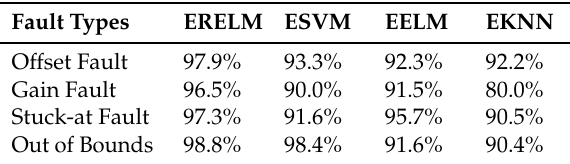
Table 3. DA with 10% induced faults.